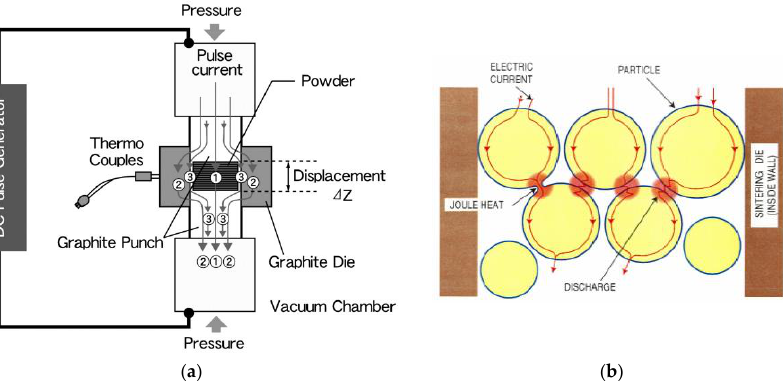
Figure 8. ( a ) ON-OFF DC pulsed current path and ( b ) pulsed current flow through powder particles.